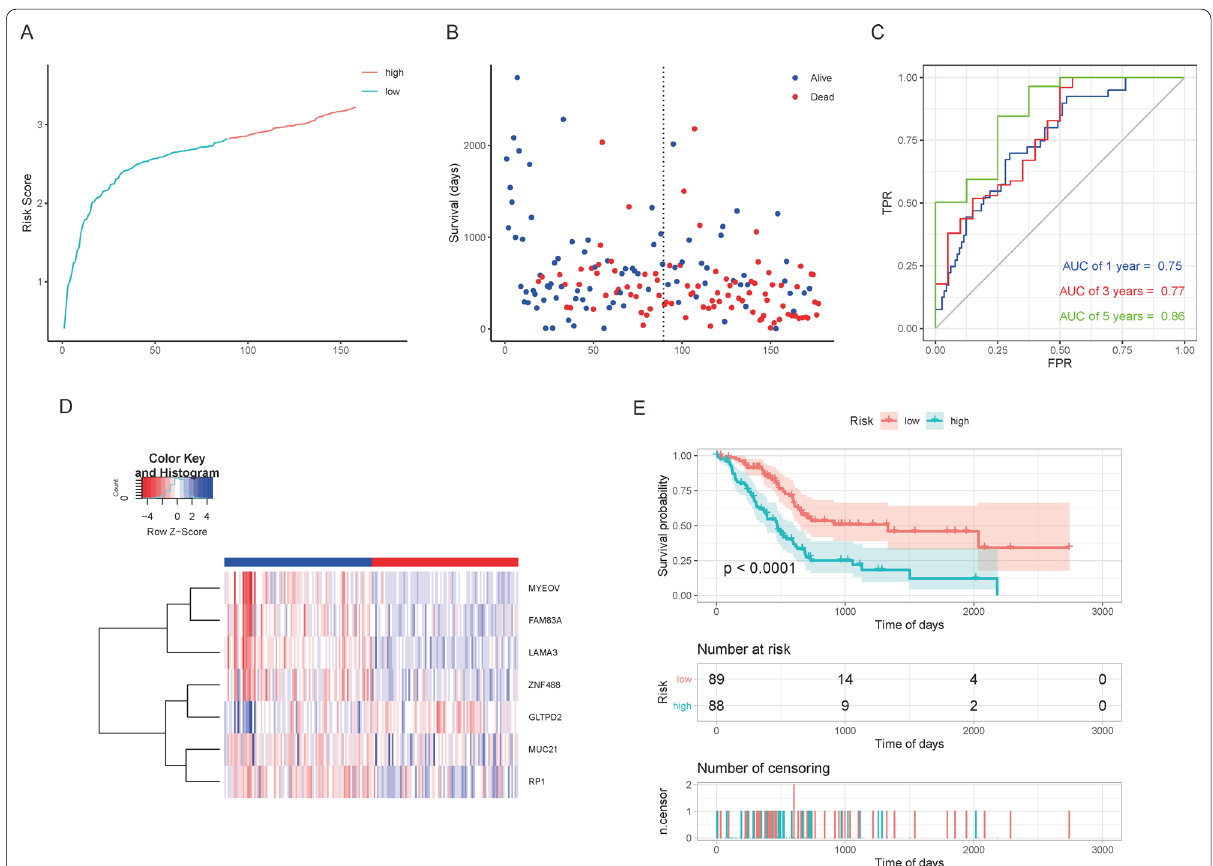
Fig. 6 The mRNA prognostic risk model. A Sample risk score curve; B Scatter plot of sample survival time. Prior to the dotted line is the low-risk group sample, while the one after the dotted line is the high-risk group sample; C ROC curves depict the prognostic risk model; D Heat map of gene expression in the model. Values are normalized with log10. The right longitudinal axis: the names of mRNAs; the left longitudinal axis: the clustering information of the mRNAs. The upregulated and downregulated mRNAs are depicted in red and blue, respectively; E KM curves for